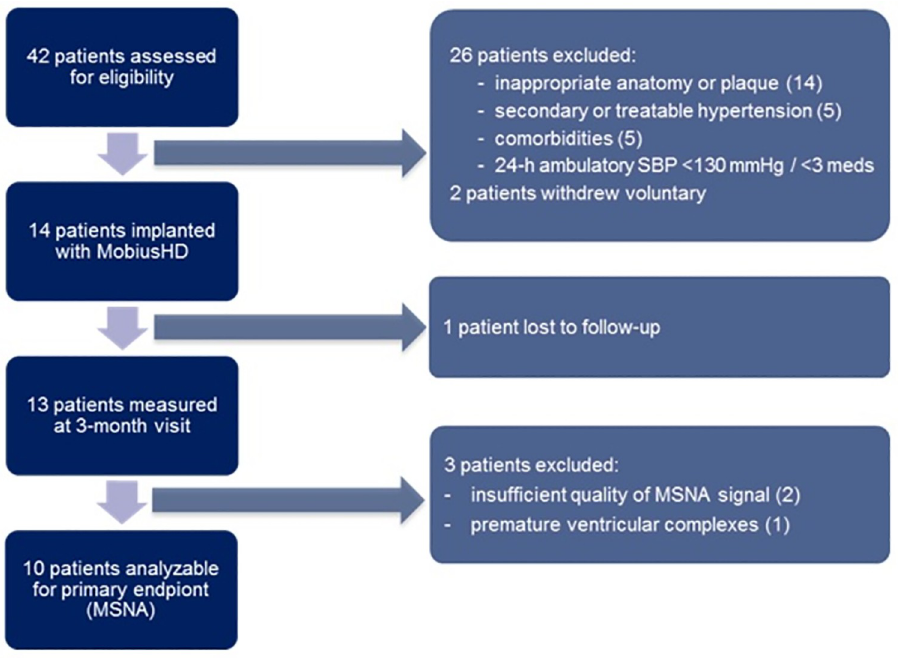
Fig 1. Flow chart of the patients screened, excluded, lost to follow-up and excluded from analysis of the primary endpoint. SBP = systolic blood pressure, meds = antihypertensive medications, MSNA = muscle sympathetic nerve